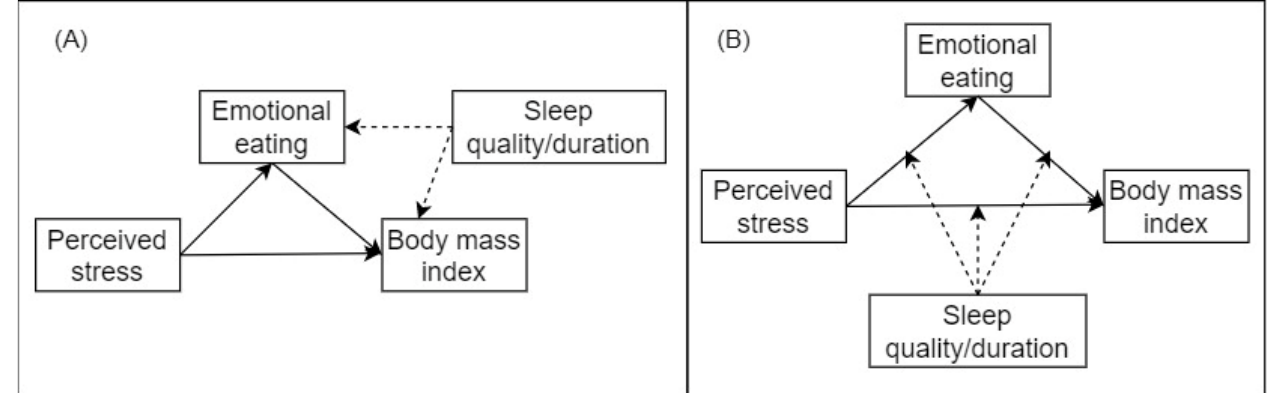
Figure 1. Conceptualization of the mediation model during the design stage: ( A ) potential confound- ing variables (sleep quality and sleep duration) introducing spurious effects in the mediation model; ( B ) the moderated mediation model proposed in Du et al.’s